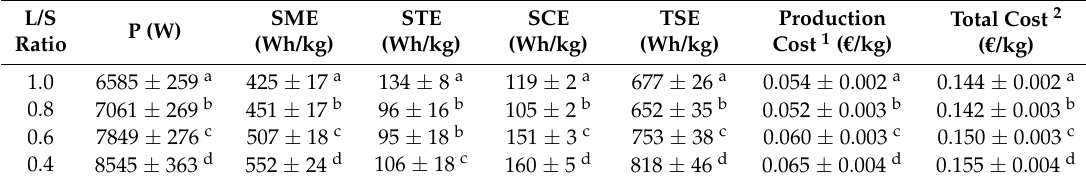
Table 3. Energy consumption and cost of the extrusion fiber refining process. L/S, liquid/solid; P, power consumption; SME, specific mechanical energy; STE, specific thermal energy; SCE, specific cooling energy; TSE, total specific